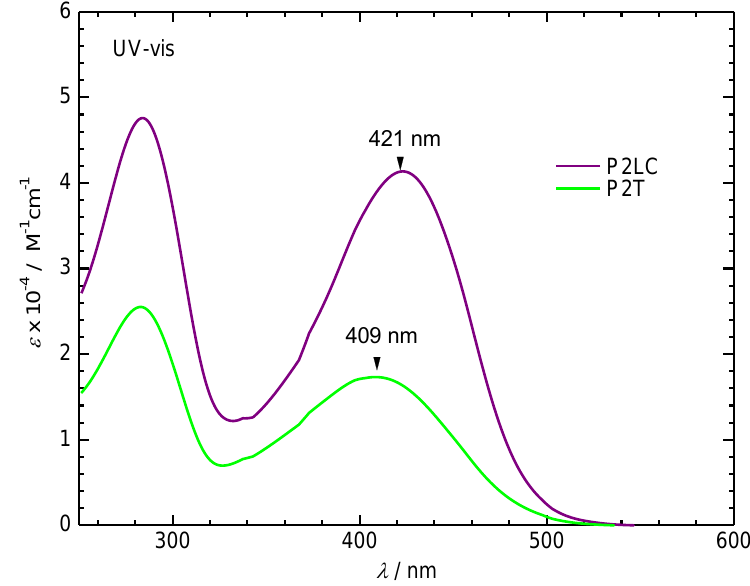
Figure 3. UV-vis absorption spectra for P2T (yellow-green line) and P2LC (purple line) at low concentration in chloroform solutions.